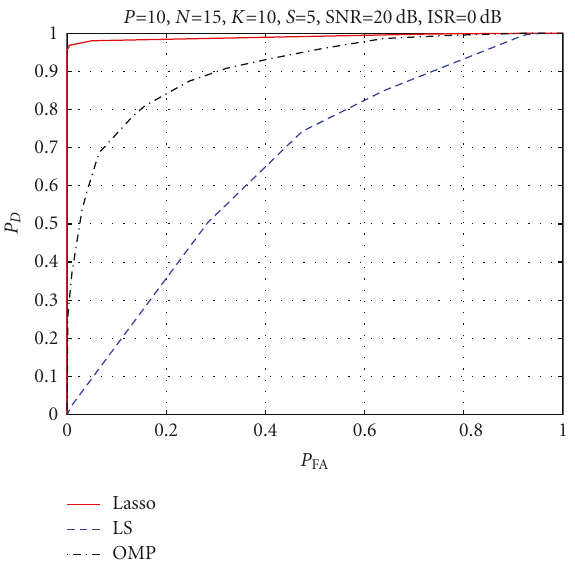
Figure 9: Normalized mean-square error of the composite channel versus SNR (asynchronous system with multipath fading channel and unknown K